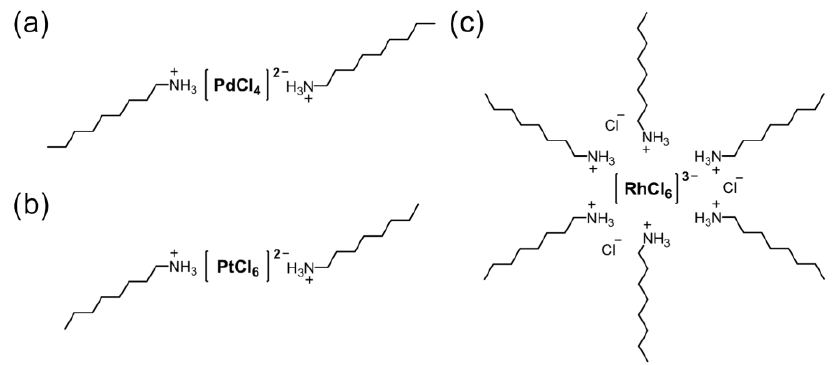
Figure 6. Expected chemical structures of the ion-pair complexes of ( a ) Pd(II) with n -nonylamine, ( b ) Pt(IV) with n -octylamine, and ( c ) Rh(III) with n -octylamine.